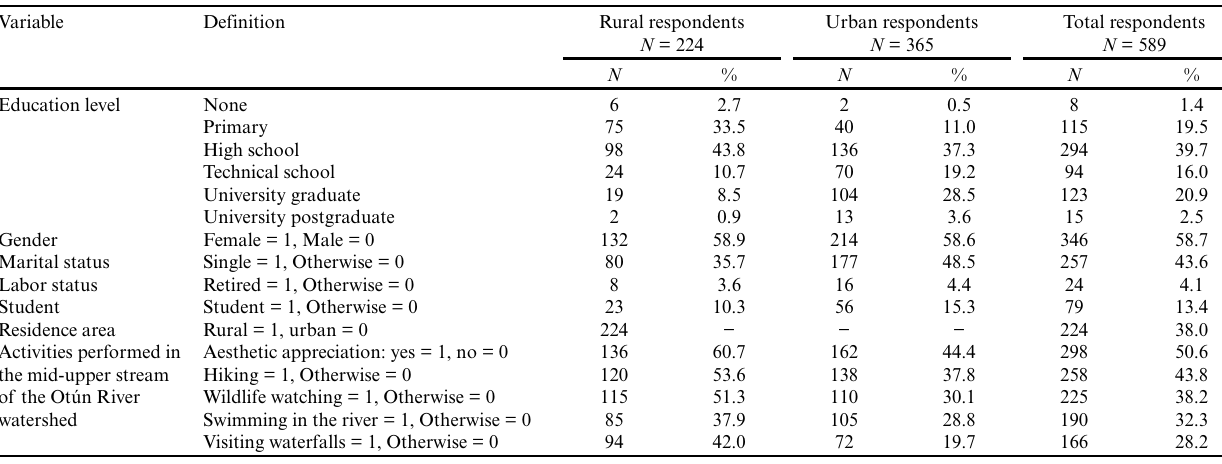
Table 2. Sample characteristics of respondents.